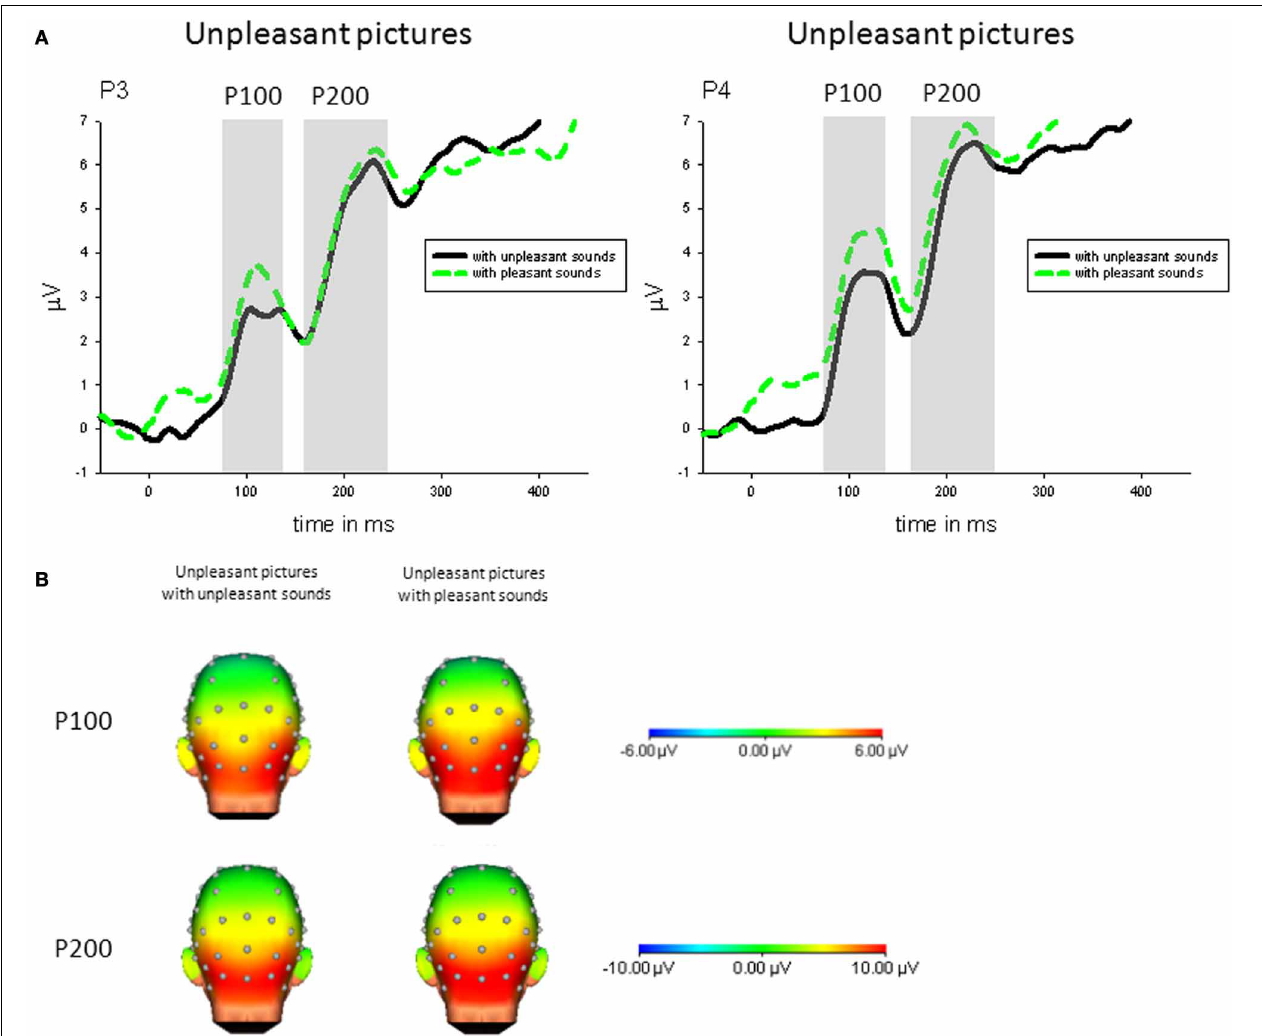
FIGURE 3 | (A) ERPs (in μ Volt) for representative channels (P3, P4) in response to unpleasant pictures with pleasant and unpleasant sounds. Gray boxes show the averaged time interval for the P100 and P200